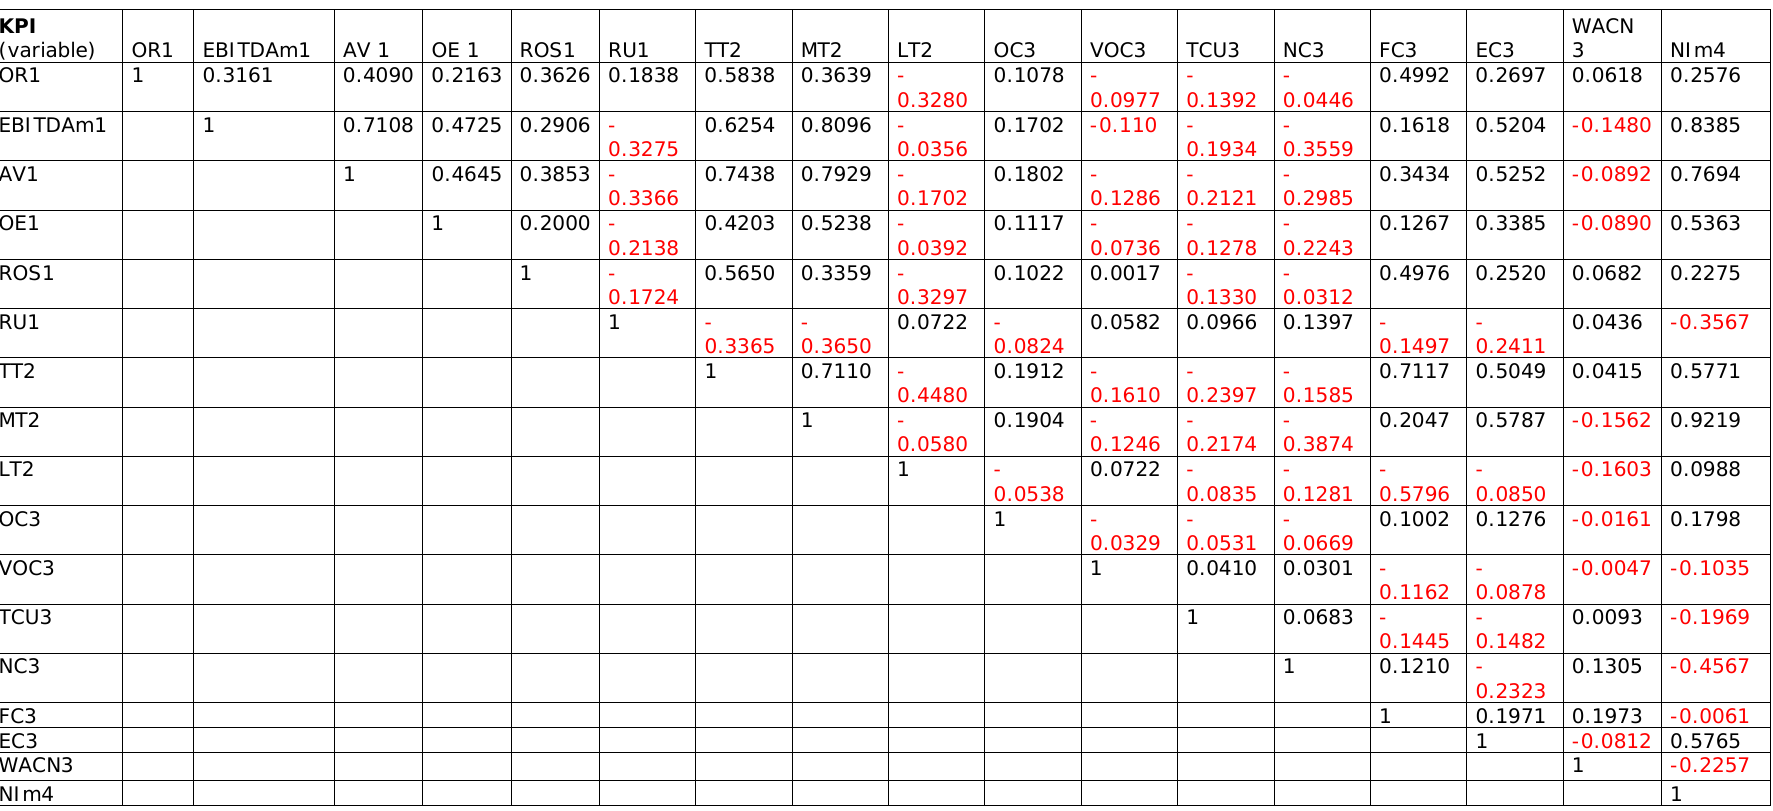
Table 8. “Correlation Matrix 2008 (Ordinal), Note: Abbreviations for variables are explained in Table